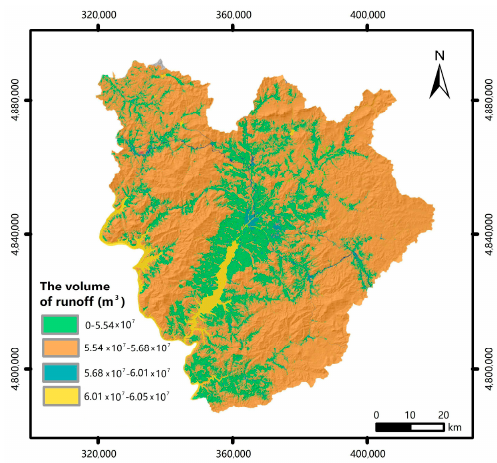
Figure 11. The volume of runoff in Jiaohe County.